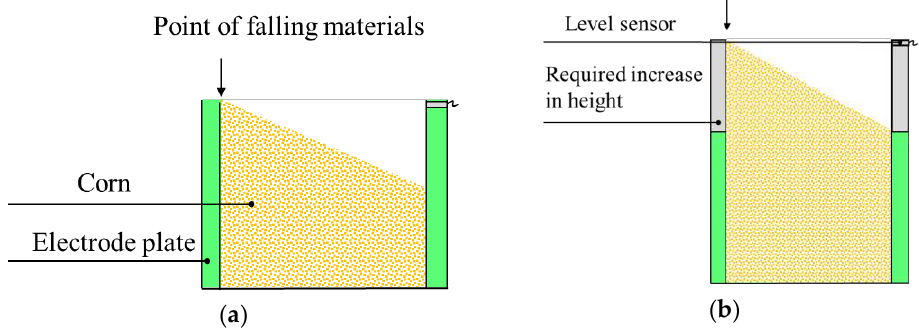
Figure 2. Improvement in moisture sensor: ( a ) underfilling of corn and ( b ) scheme for increasing chamber height.